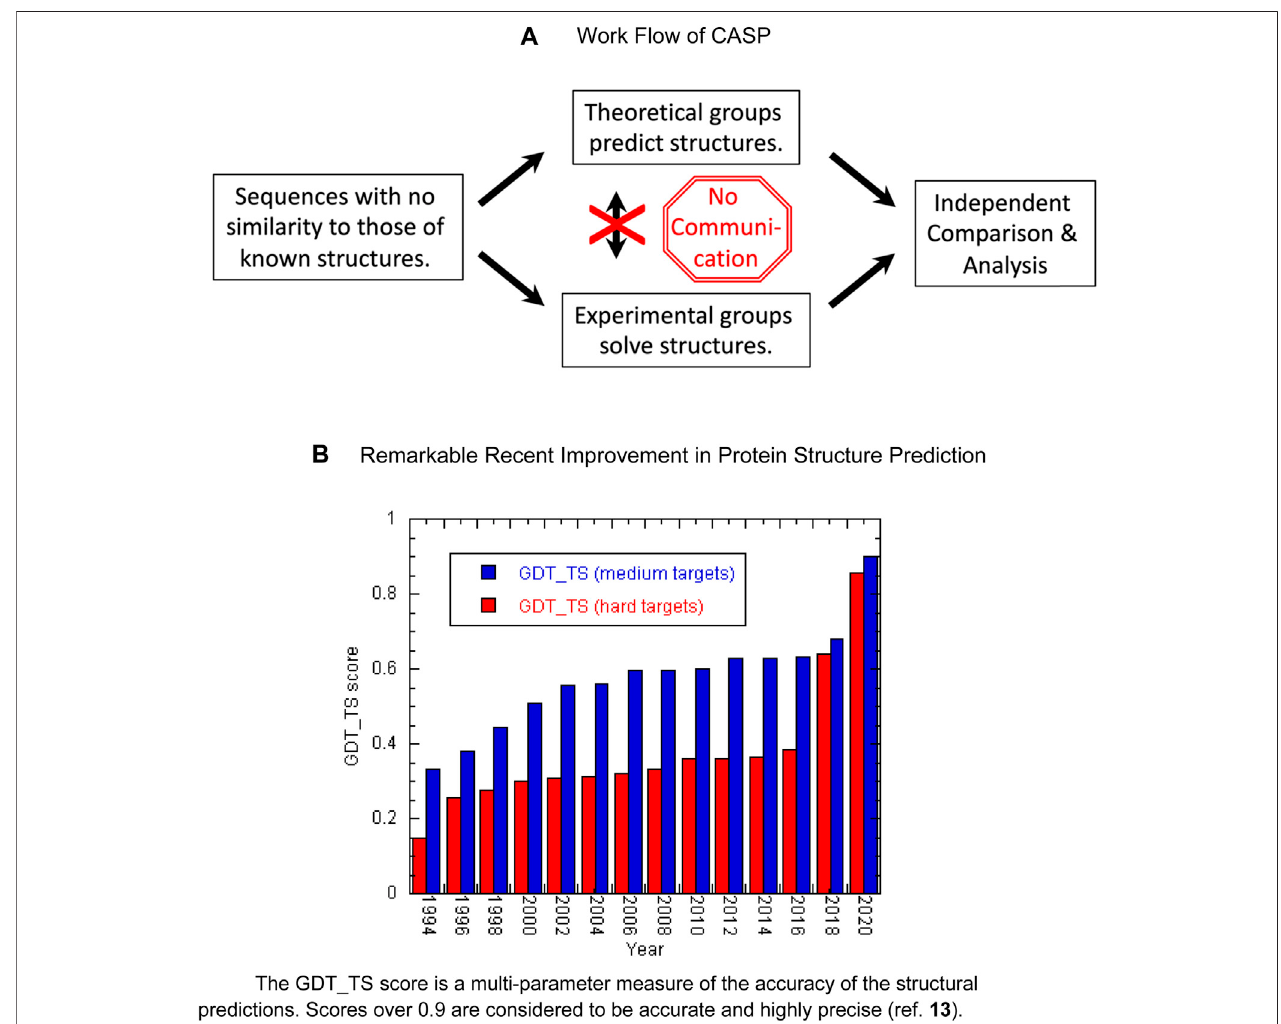
FIGURE 1 | (A) Work fl ow of CASP. (B) Remarkable recent improvement in protein structure prediction. The GDT_TS score is a multi-parameter measure of the accuracy of the structural predictions. Scores over 0.9 are considered to be accurate and highly precise (ref.